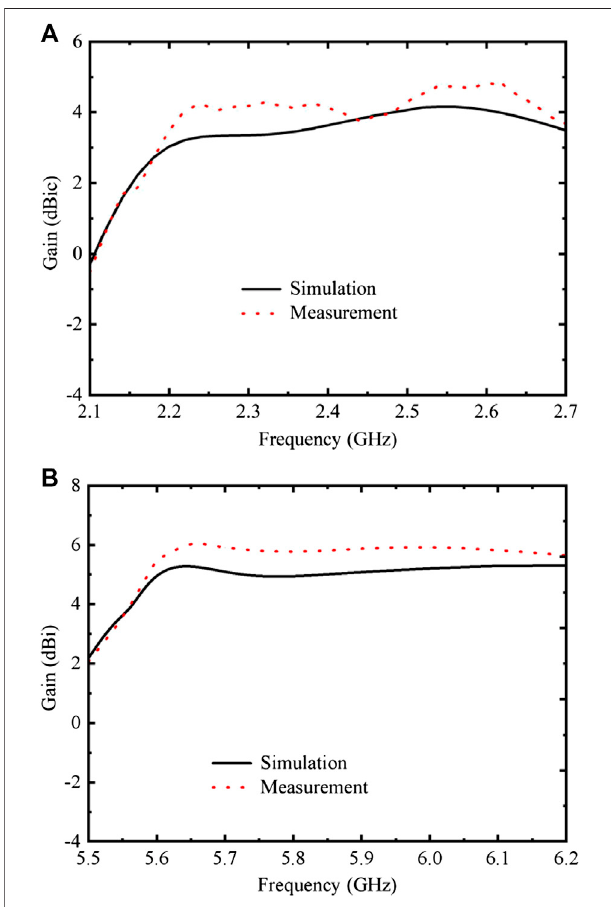
FIGURE 5 | Simulated and measured antenna gains: (A) low band; (B) high band.